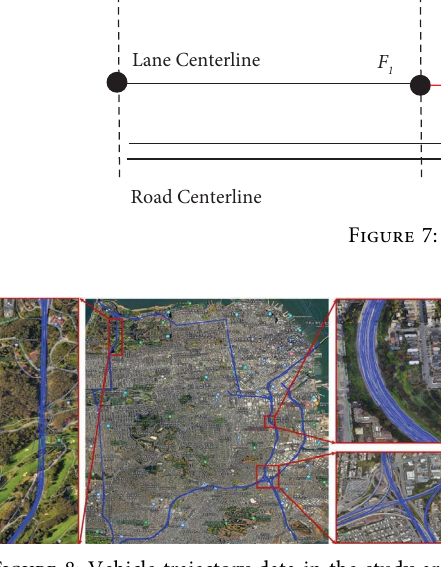
Figure 8: Vehicle trajectory data in the study area.